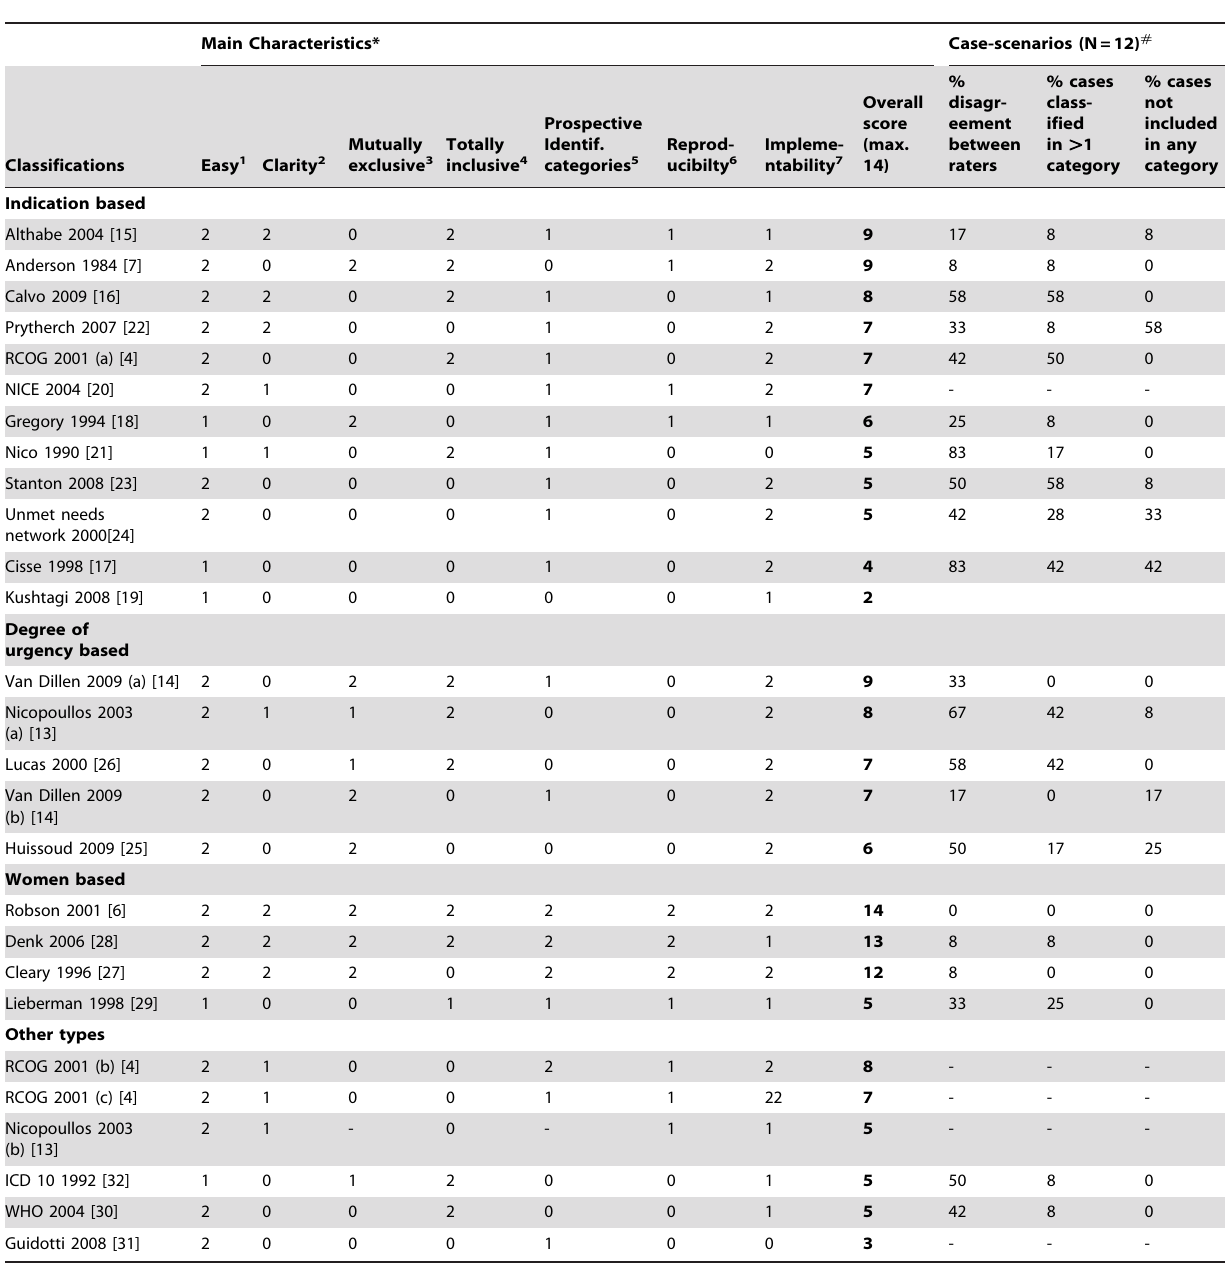
Table 2. Main characteristics of 27 classifications for caesarean section and results from the 12 case-scenarios.